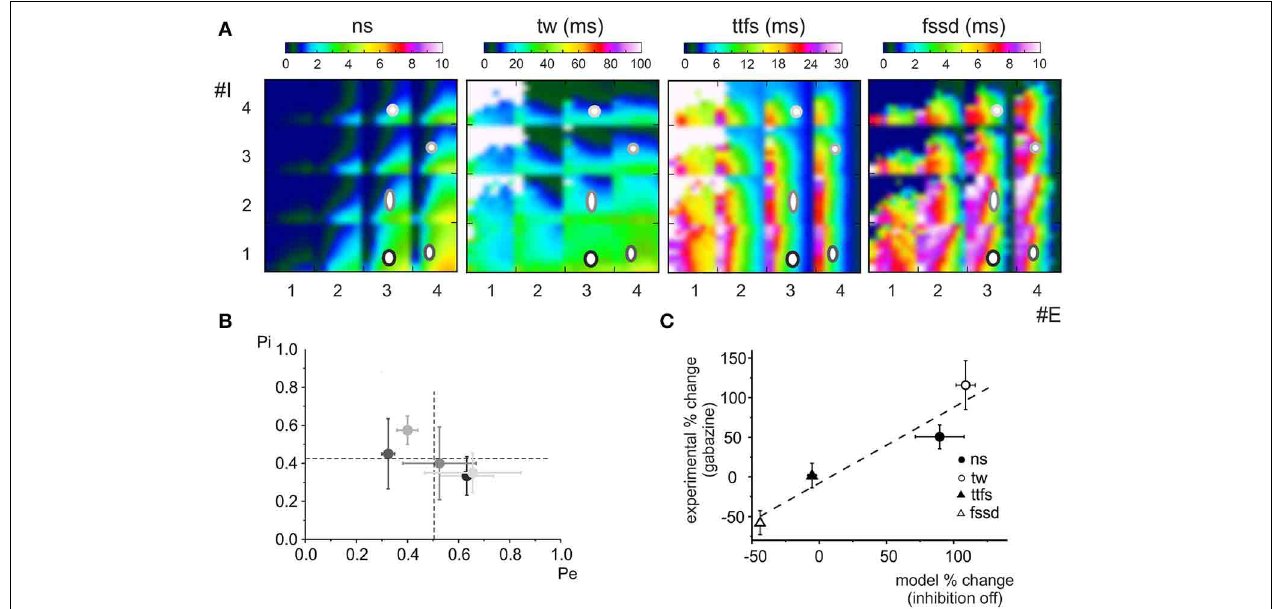
FIGURE 6 | Model predictions of experimental GABA-A receptor blockage. (A) The experimental parameters reported in Figures 1C,E are reported on the control E/I response space for the 5 cells showing E < 4 and I < 4 yielding the corresponding Pe and Pi values. The position of symbols and their size correspond to the mean ± MSE of data values extrapolated from number of spikes ( ns ), time window ( tw ), time to first spike ( ttfs ) and first spike standard deviation ( fssd ) (same gray scale as in B ). (B) The Pi and Pe values obtained in A and averaged across the different parameters ( sn , tw ,